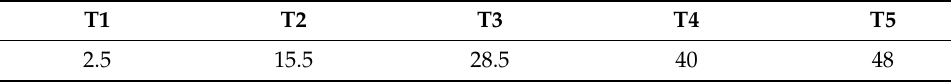
Table 2. Coordinates of the cross-sections (mm).